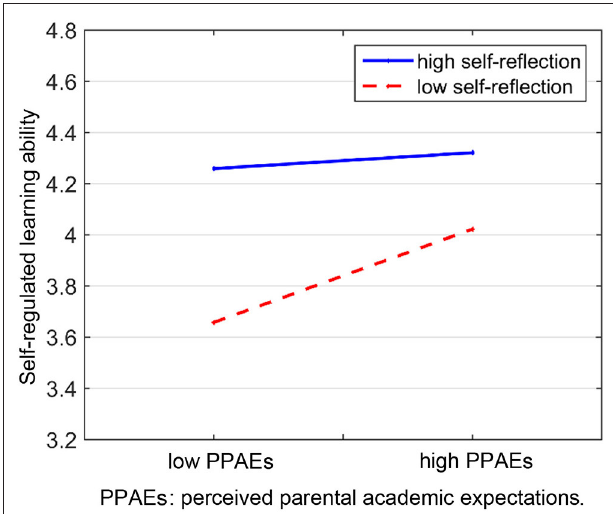
FIGURE 3 | Simple slopes of perceived parental academic expectations (PPAEs) predicting SRL ability with low (one SD below M) and high (one SD above M) levels of